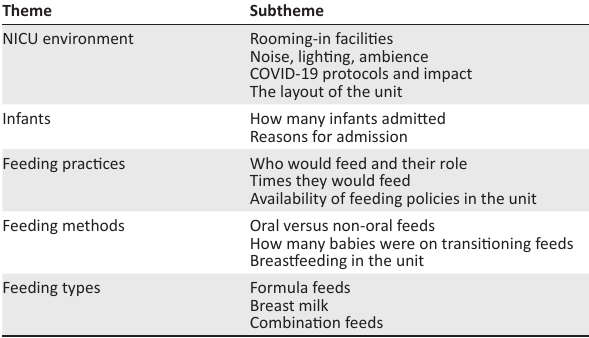
TABLE 2: Themes in the observation tool.